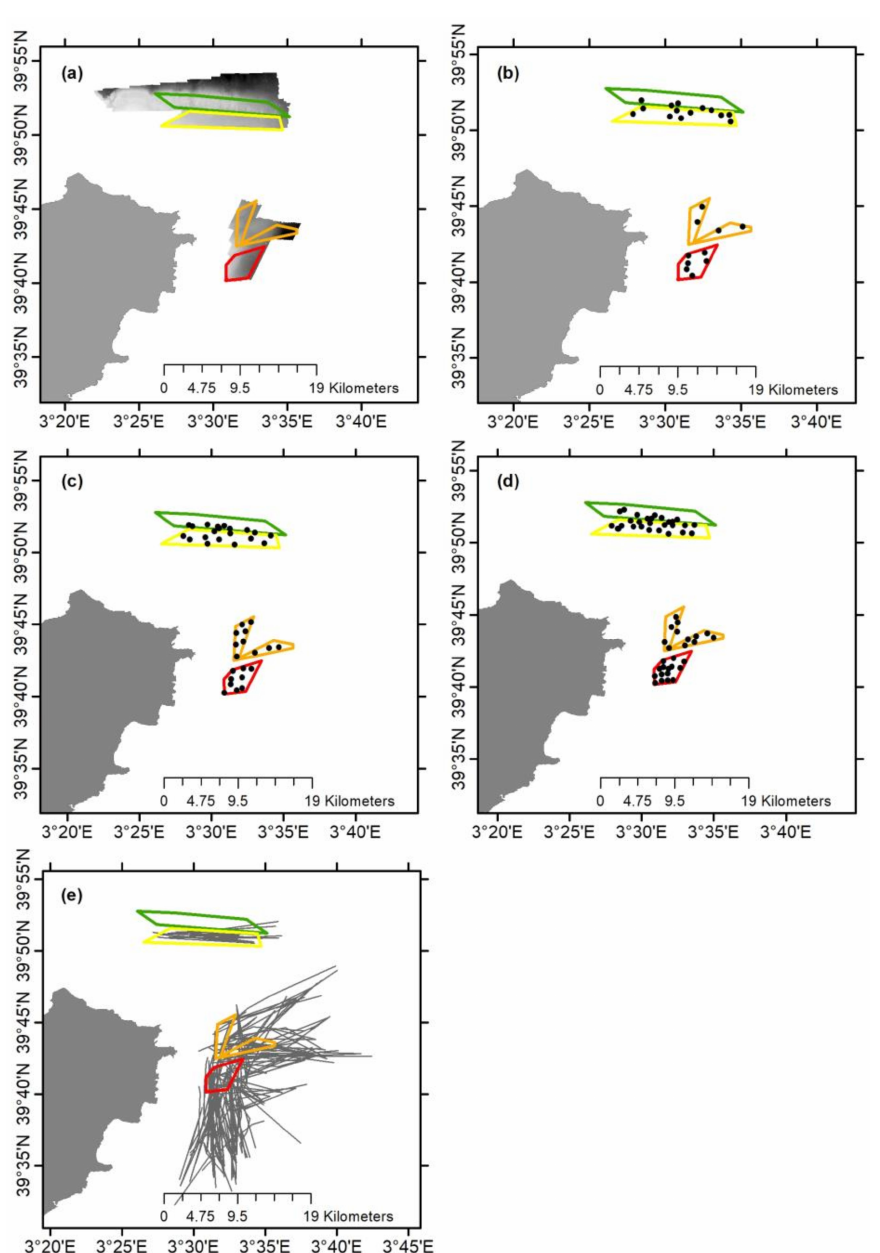
Figure 2. Map of the Menorca Channel (Balearic Islands, western Mediterranean) showing the location of sampling stations: ( a ) bathymetry-derived maps; ( b ) samples collected with Shipek dredge; ( c ) samples collected with beam trawl; ( d ) video transects made with TASIFE photogrammetric sledge; and ( e ) commercial hauls of the trawling fleet sampled from observers onboard. The four areas with different levels of bottom trawl fishing effort (Non-Impacted: green; Low effort history: yellow; Medium effort history: orange; High effort: red) compared in the present study are also